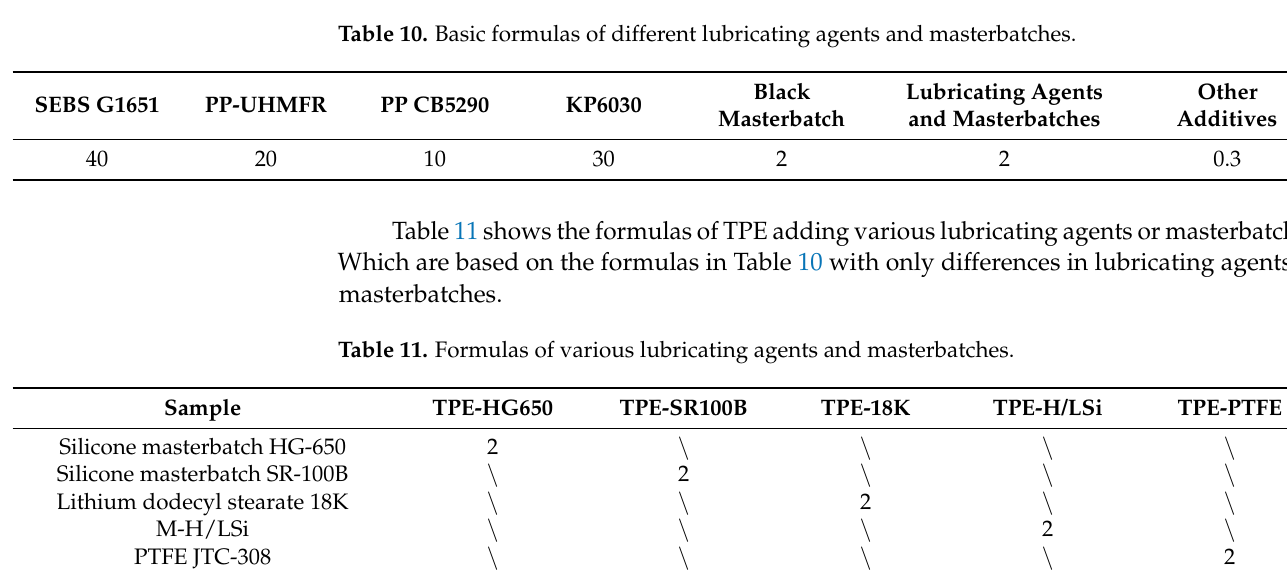
Table 10. Basic formulas of different lubricating agents and masterbatches.